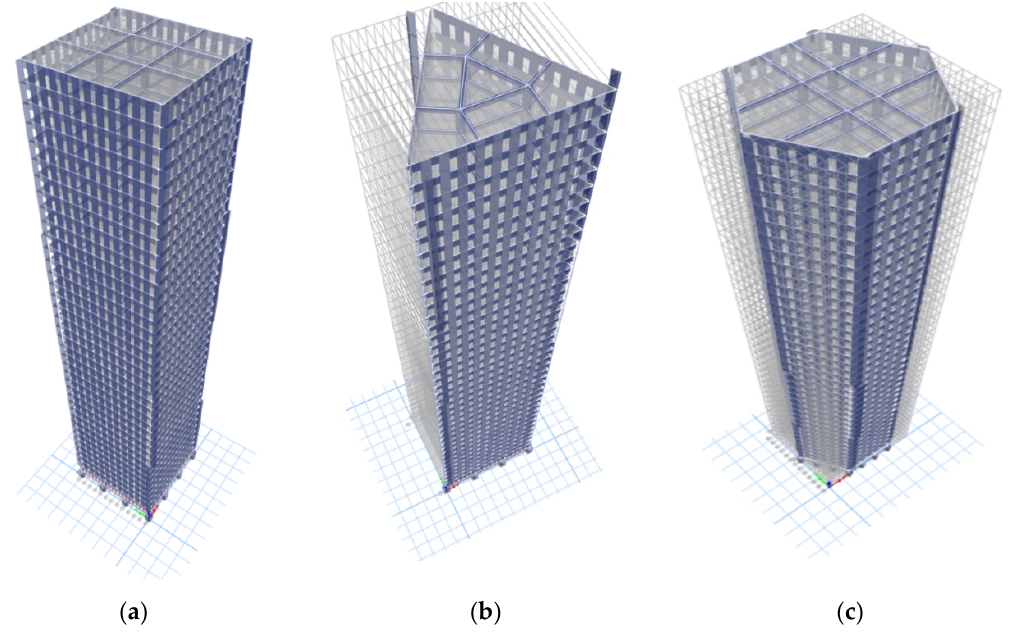
Figure 3. Three-dimensional view of 40-story models in ETABS Software: ( a ) rectangular, ( b ) triangular and ( c ) hexagonal.